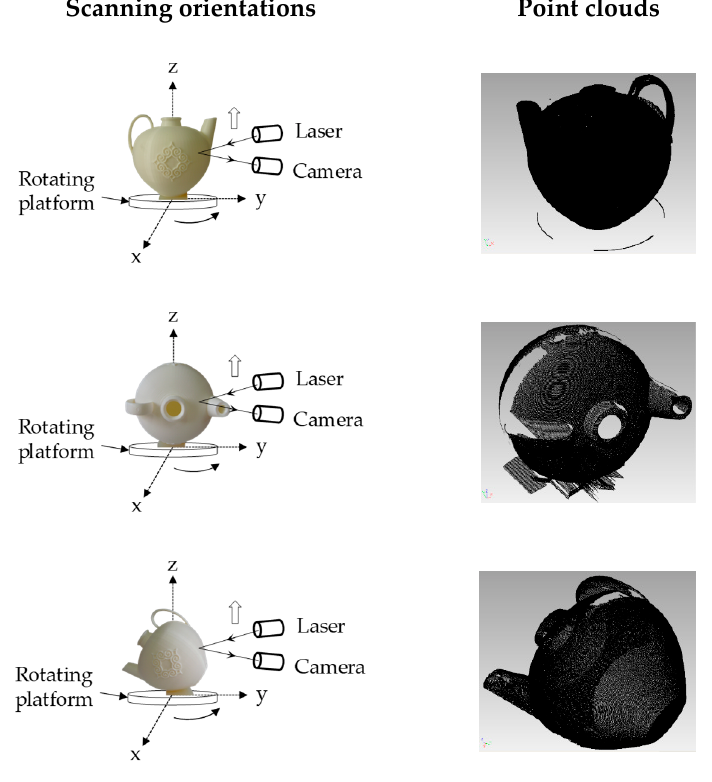
Figure 22. Point cloud registration from different orientations.